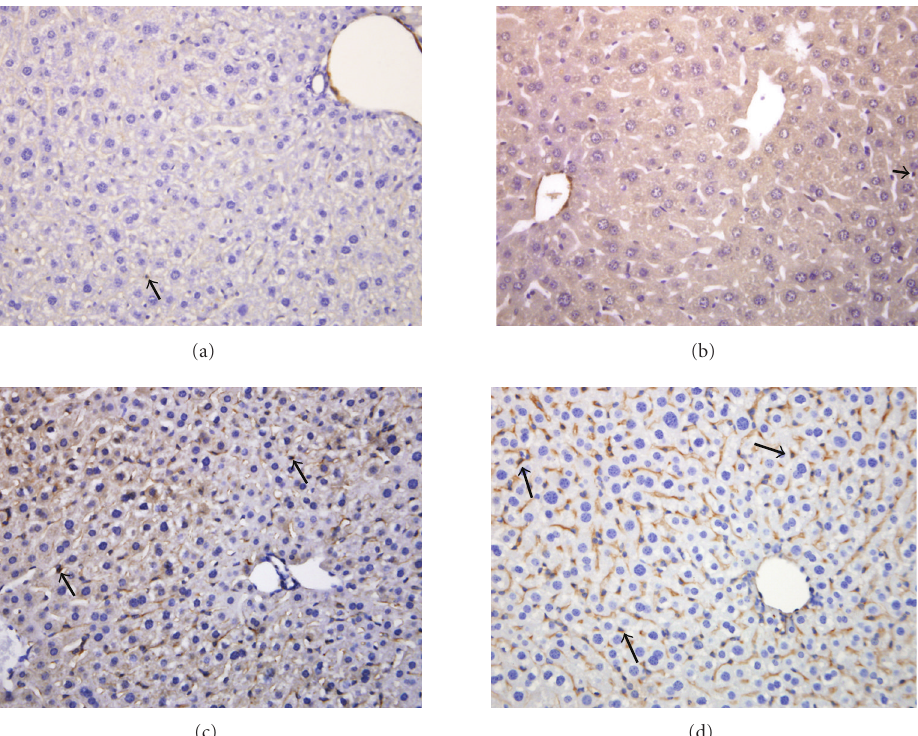
Figure 5: Representative immunohistochemistry from mice livers showing SMA in young (a) and old (b) mice, and desmin immunostaining in young (c) and old (d) mice (magnification ×